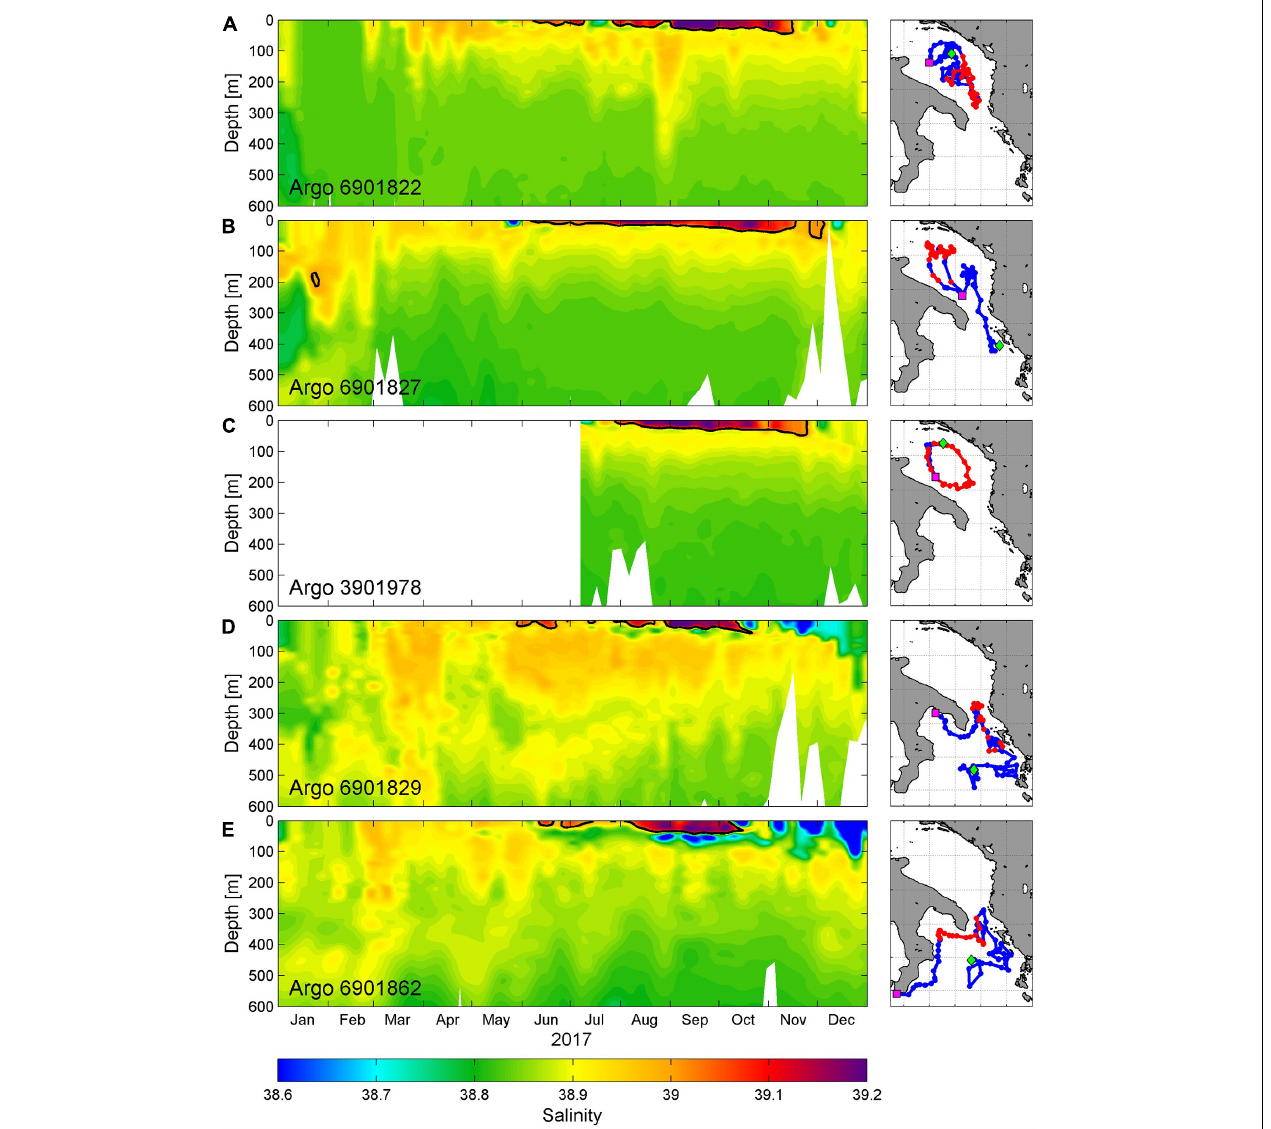
FIGURE 3 | (A) Hovmöller diagram of salinity data for Argo float 6901822 in the first 600 m in 2017 (left panel) with corresponding float trajectory (right panel). Thick black line in the left panel denotes 39.0 salinity contour, while the corresponding part of the trajectory is colored in red in the right panel. The location of the first vertical profile in 2017 is denoted by green diamond in right panel, while the last vertical profile in 2017 is marked with magenta square. (B–E) As in panel (A) except for Argo floats 6901827, 3901978, 6901829, and 6901862,